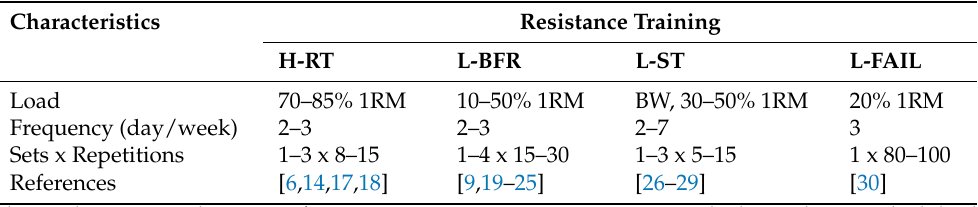
Table 1. Characteristics of each type of resistance training for improving skeletal muscle mass in older adults based on previous studies.